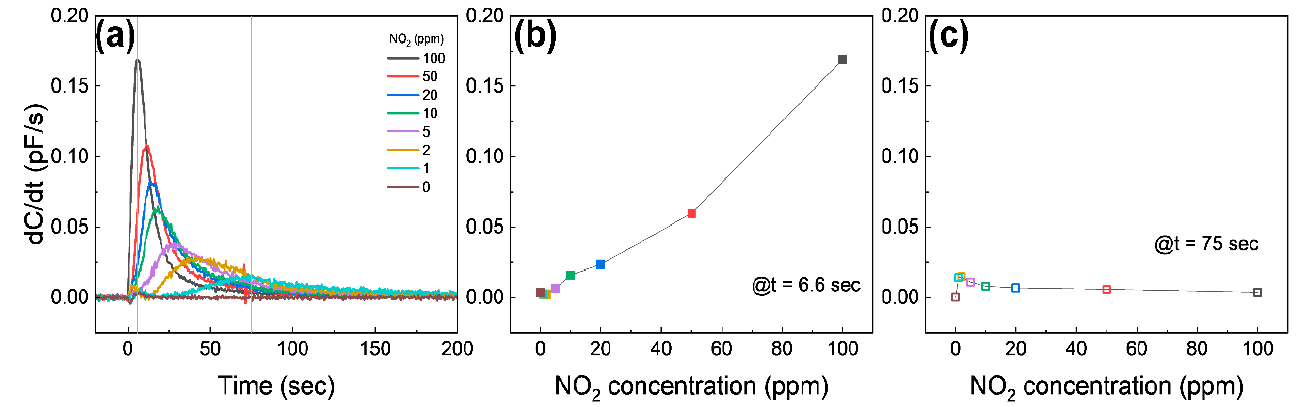
Figure 5. ( a ) Differential capacitance as a function of time at different NO 2 concentrations. The gray solid lines are at 6.6 s and 75 s, respectively. ( b ) and ( c ) show the differential capacitance at 6.6 s and 75 s from ( a ), respectively.